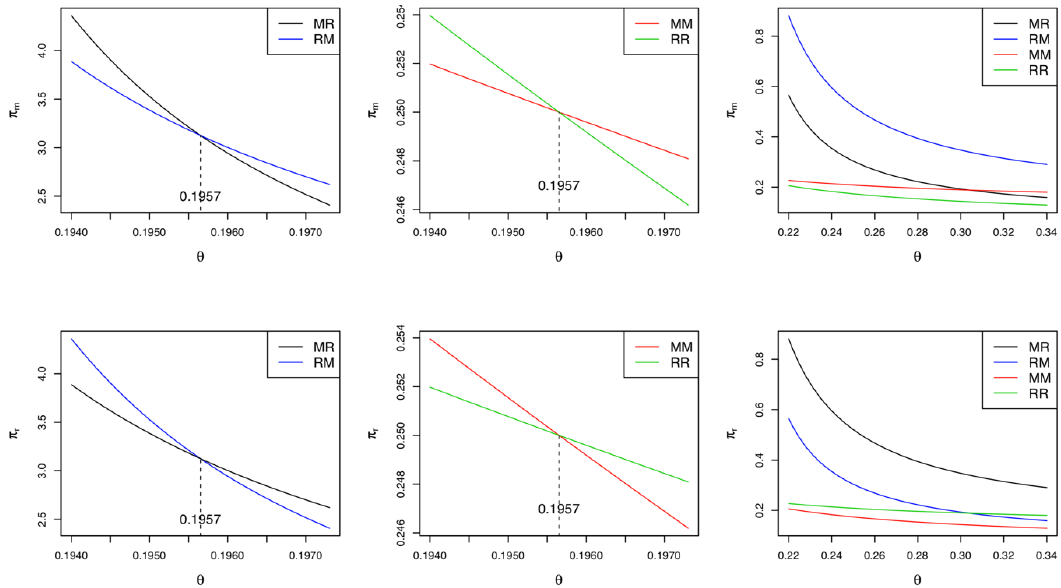
Figure 7. Comparisons of the profits when single supply chain member makes the green innovation